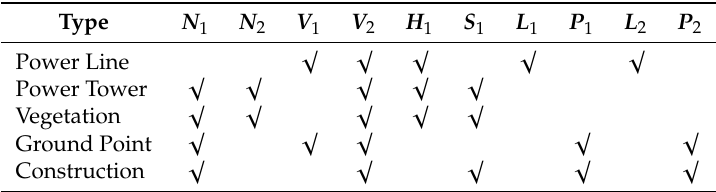
Table 1. Key features selected for different objects.